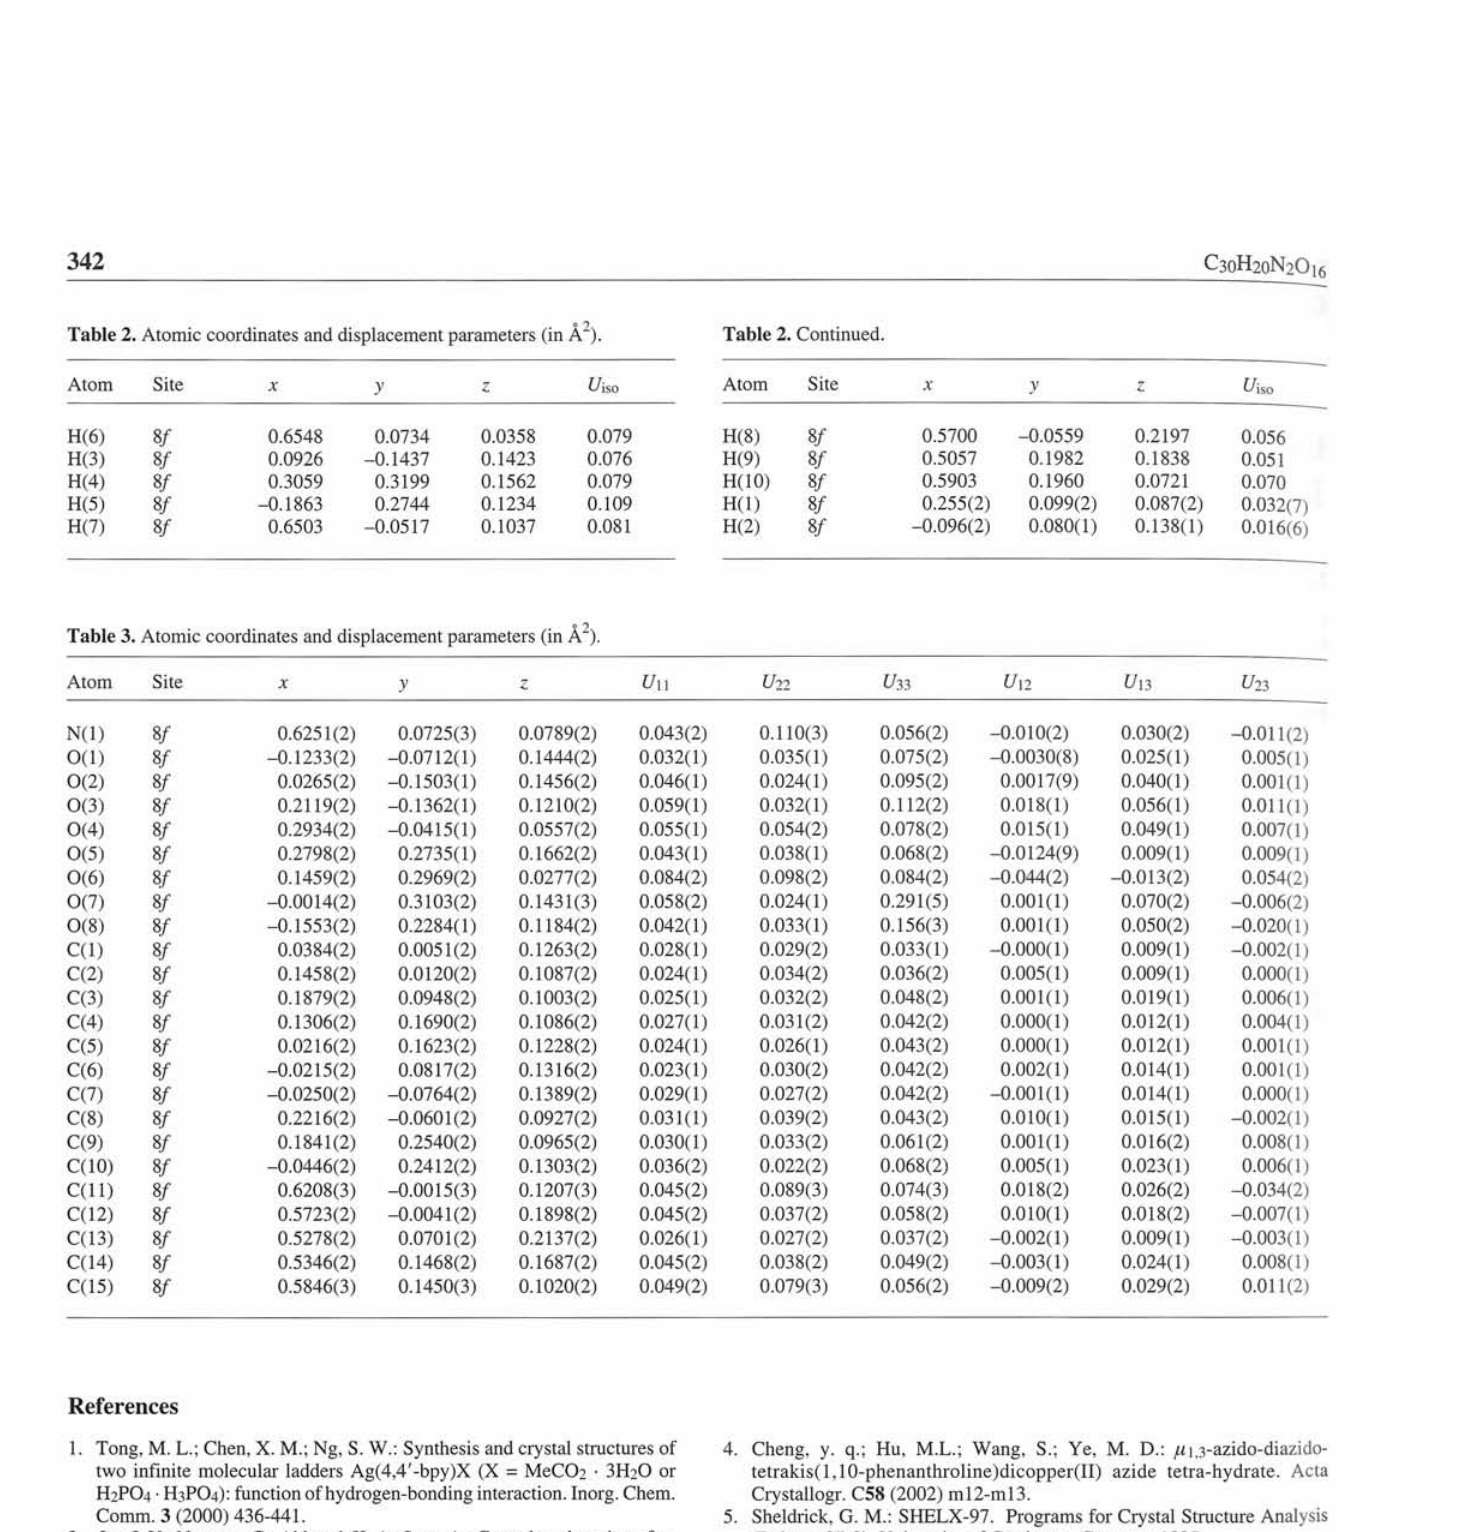
Table 2. Atomic coordinates and displacement parameters (in Â 2 ). Table 2. Continued.